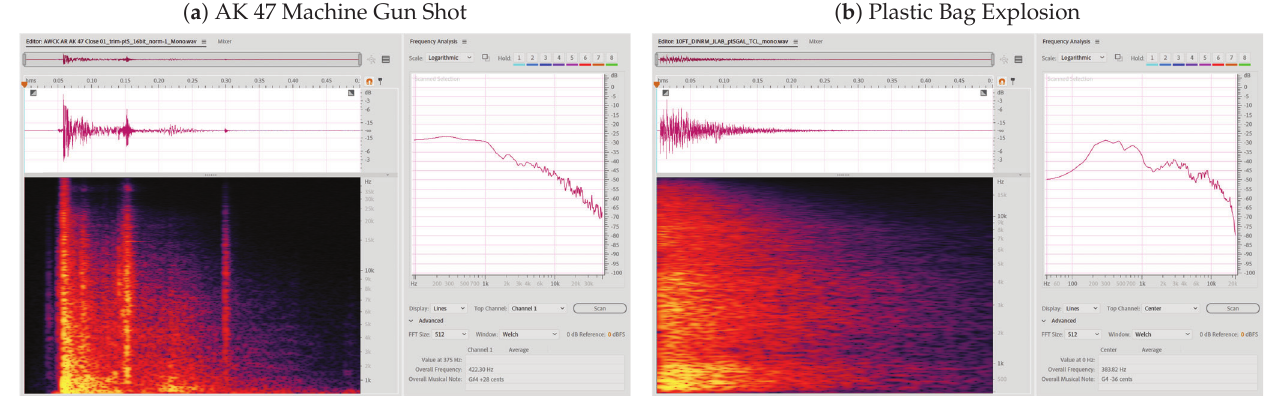
Figure 7. Comparison ofspectrogram plots between ( a ) an AK47 gunshot and ( b ) a plastic bag